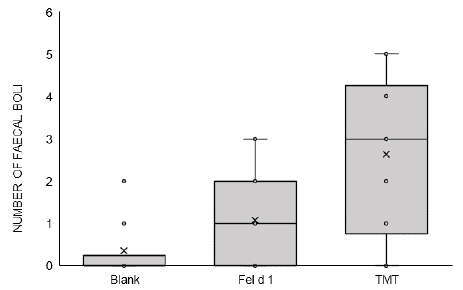
Figure 6. Number of faecal boli. Statistical analysis was performed with a Scheirer-Ray-Hare test (non-parametric conditions). The significance threshold is fixed at 5%.